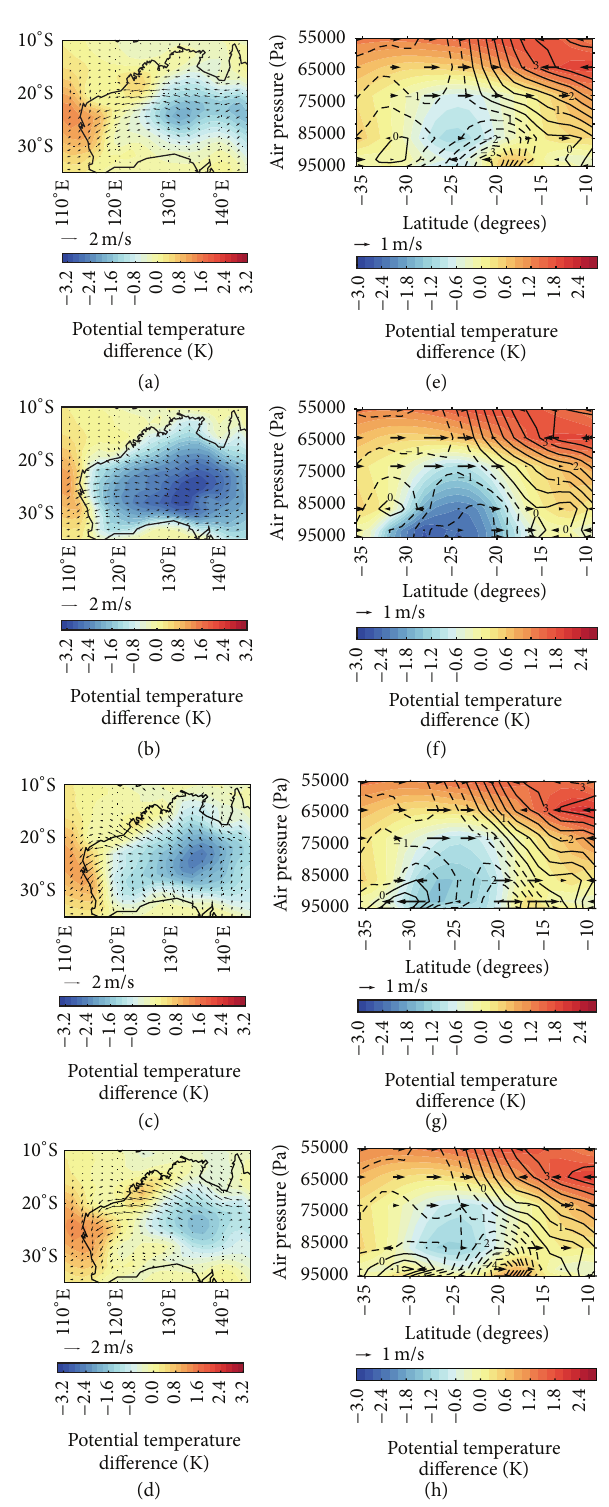
Figure 6: (a)–(d) show the difference in climatological mean (1979–2001) potential temperature (K) and horizontal wind speed (ms −1 ) at 925 hPa between A1.3 and A1.0 at 0800, 1400, 2000, and 0200 AWST, respectively. (e)–(h) show the difference in potential temperature and horizontal wind speed at 125 ∘ E between A1.3 and A1.0 at 0800, 1400, 2000, and 0200 AWST, respectively. The colored contours show the difference in potential temperature. The meridional and vertical wind speeds are indicated by the arrows (scale under each figure) and the zonal wind speeds are shown as the black contours. The dotted and solid black lines represent the zonal flow into and out of the page, respectively. The vertical component is multiplied by a factor of 100 to make it